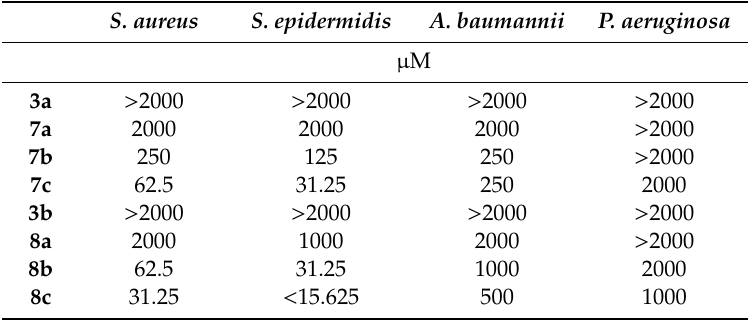
Table 1. Minimum inhibitory concentration (MIC) of Gram-positive and Gram-negative